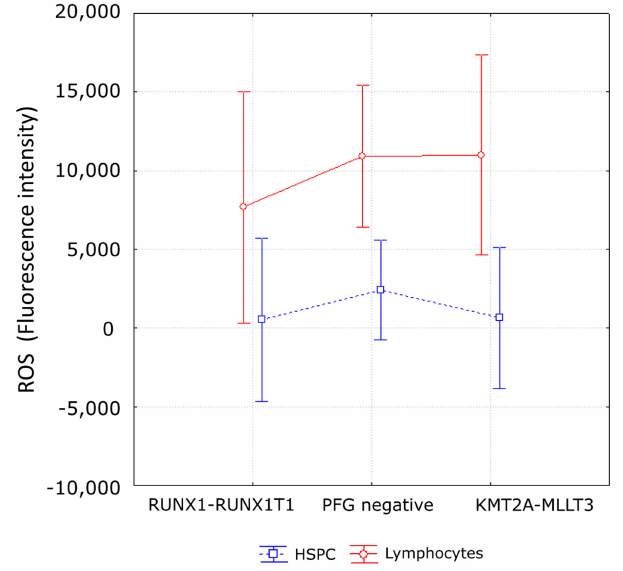
Figure 4. ROS levels in UCB cells of PFG + /PFG − probands. The mean values of ROS level from 3 RUNX1-RUNX1T1 PFG + , 3 KMT2A-MLLT3 PFG + , and 3 PFG − probands are shown. Lymphocytes and HSPCs are visualized separately. The error bars represent 95% confidence interval.